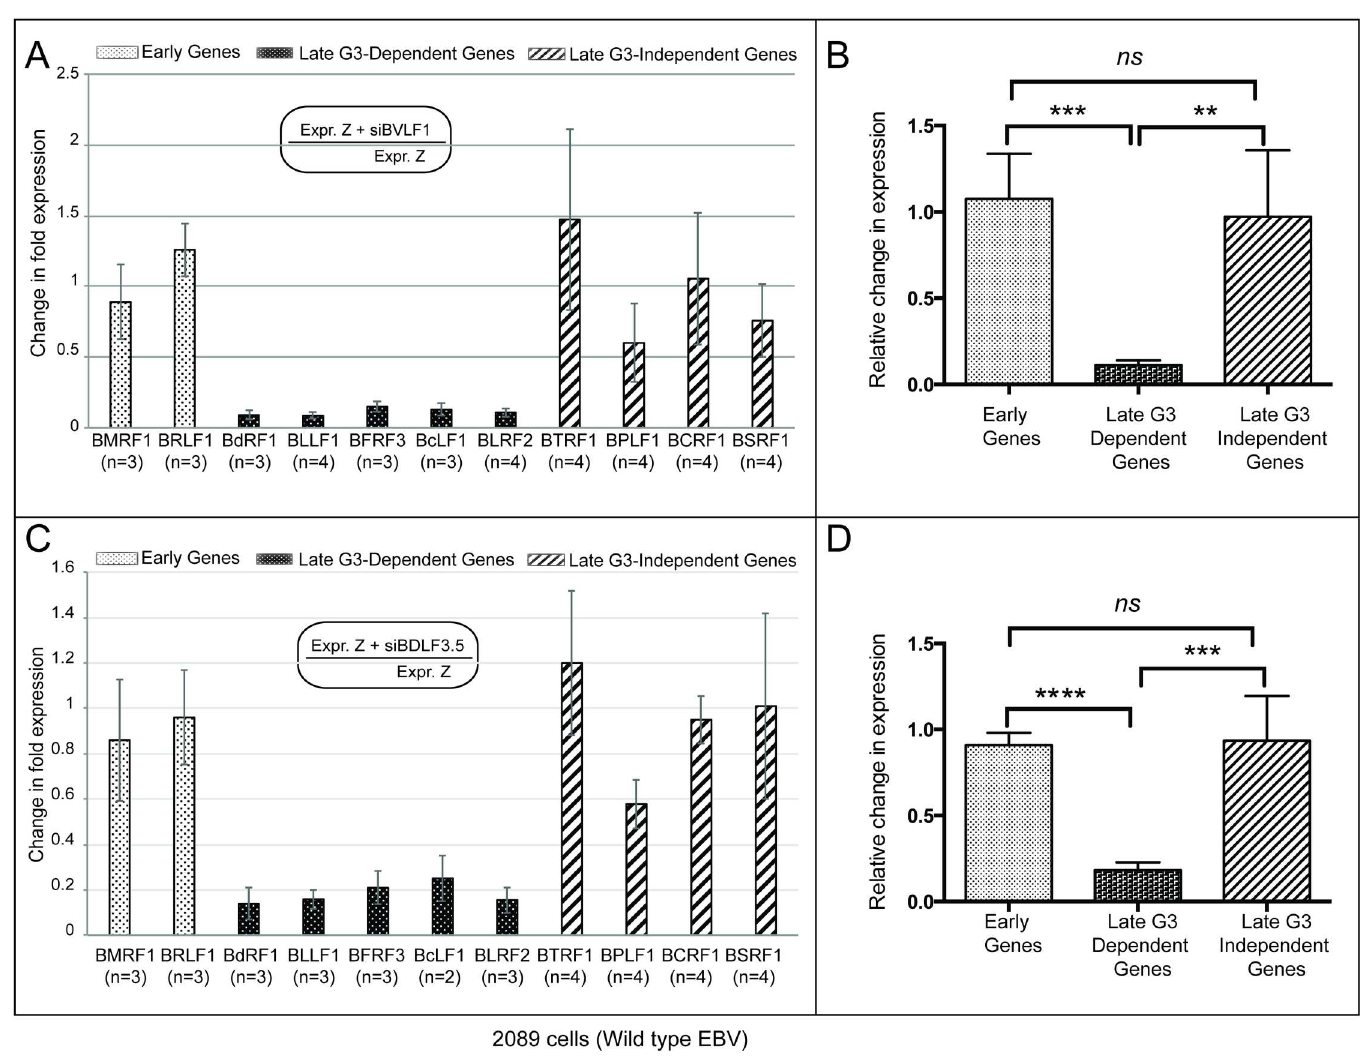
Fig 8. BGLF3-independent late genes are expressed in the absence of BVLF1 and BDLF3.5. A and C) The bar graphs depict the effect of silencing BVLF1 and BDLF3.5 on expressionof three groups of lytic genes: early, late BGLF3-dependentand late BGLF3-indpendent. Expression of these genes was determined using RT-qPCR of total RNA purifiedfrom 2089 cells transfected with ZEBRA expressionvector in the absenceand presenceof the indicated siRNAs. The data was assembled from replicate experiments; the numberof experiments is denotedfor each transcript by letter (n). B and D are graphs that illustrate collective changesin expression among the three groupsof EBV lytic genesas a result of knockingdown BVLF1 or BDLF3.5. Asterisks denote statistically significantdifferences; ns, mark non-statistically significantdifference; G3, BGLF3, and Z,